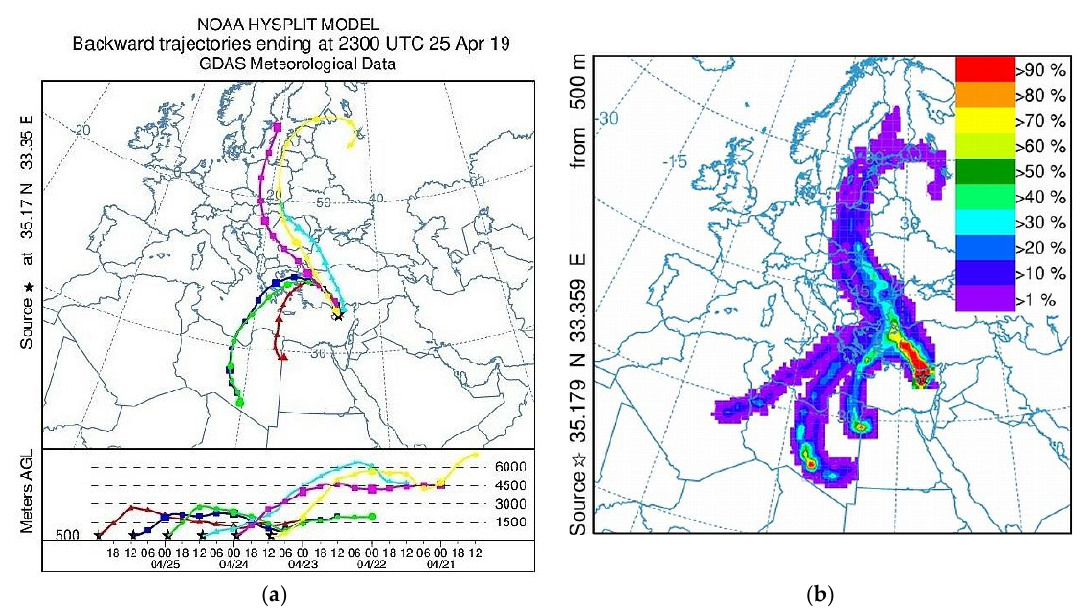
Figure 10. ( a ) Backward trajectory of the air mass at 23 UTC and ( b ) trajectory frequency ( b ) on 25 April 2019, Nicosia, Cyprus. HYSPLIT calculation. Different colors at the bottom scale of vertical air movements at ( a ) correspond to different air mass trajectory for a particular day that comes from a calculated altitude to altitude of 500 m (AGL). For example, the yellow line shows air moving from an altitude above 6000 m (AGL) that comes by trajectory (marked on the map the same color) and was detected at Nicosia at an altitude of 500 m AGL at 12 h on 23 April. Red color corresponds to 00 h on 26 April, blue — to 12 h on 25 April, green — to 00 h on 25 April, light blue — to 12 h on 24 April, and pink — to 00 h on 24 April.